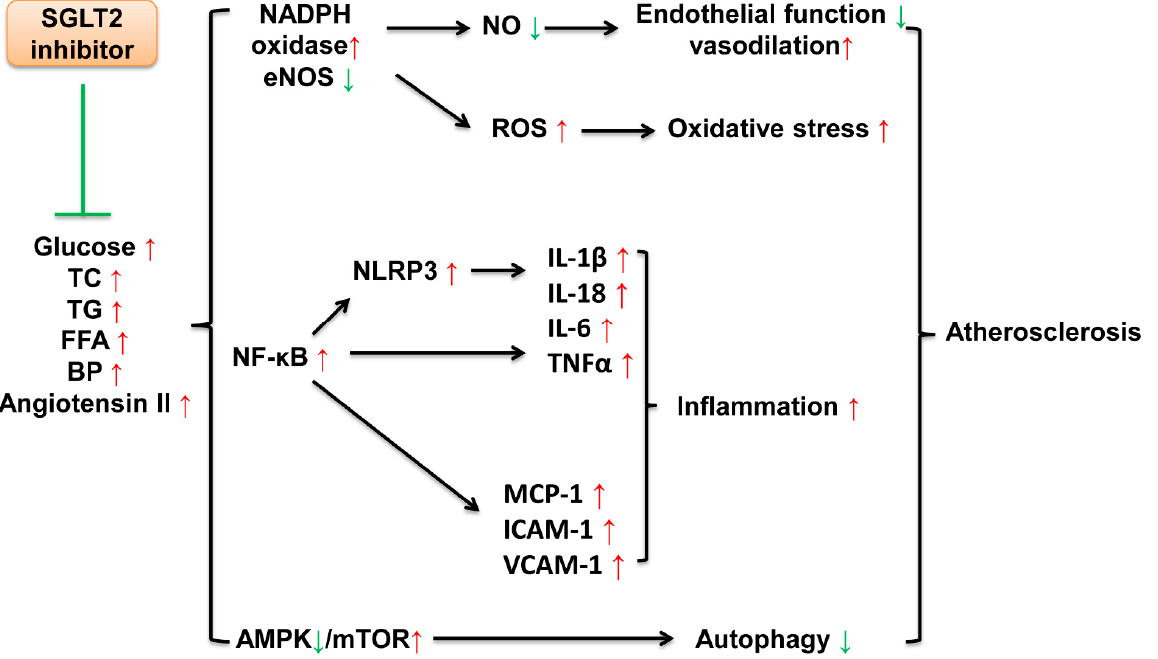
Figure 1. Mechanisms of SGLT2 inhibitors against atherosclerosis. Elevated metabolic characteristics including glucose, TC, TG, FFA, BP and angiotensin II accelerate the progression of atherosclerosis via the dysregulation of endothelial function, vasodilation and autophagy and activating oxidative stress and inflammation. SGLT2 inhibitors attenuate the alterations caused by these metabolic changes. TC, total cholesterol; TG, triglyceride; FFA, free fatty acid; BP, blood pressure; NADPH, nicotinamide adenine dinucleotide phosphate; NO, nitric oxide; eNOS, endothelial nitric oxide synthase; ROS, reactive oxygen species; NF- κ B, nuclear factor kappa-B; NLRP3, nucleotide-binding oligomerization domain-like receptor family pyrin domain containing 3; IL, interleukin; TNF α , tumor necrosis factor α ; MCP-1, monocyte chemoattractant protein 1; ICAM-1, intercellular cell adhesion molecule-1; VCAM-1, vascular cell adhesion protein 1; AMPK, AMP-activated protein kinase; mTOR, mechanistic target of rapamycin; ↑ , increase; ↓ ,